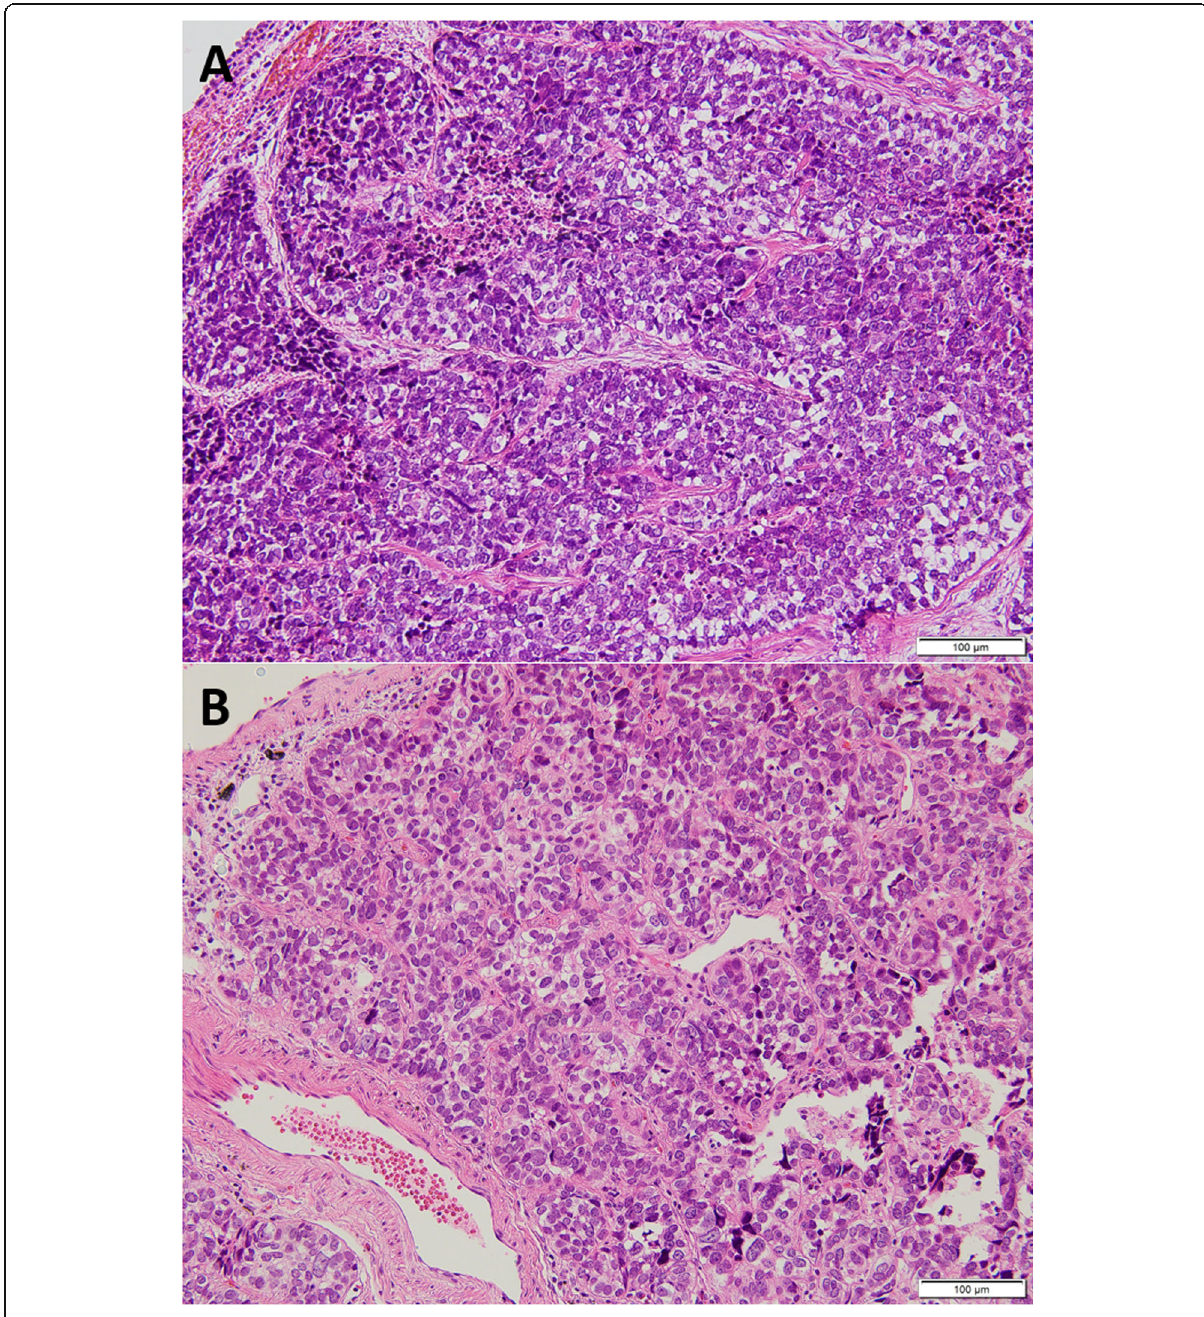
Fig. 1 a HE staining of the eyelid tumor. Tumor cells with atypical nuclei and foamy cytoplasm expanded to form a net-like structure (magnification × 200). b HE staining of the pulmonary lesion. The pathological findings were similar to those of the primary